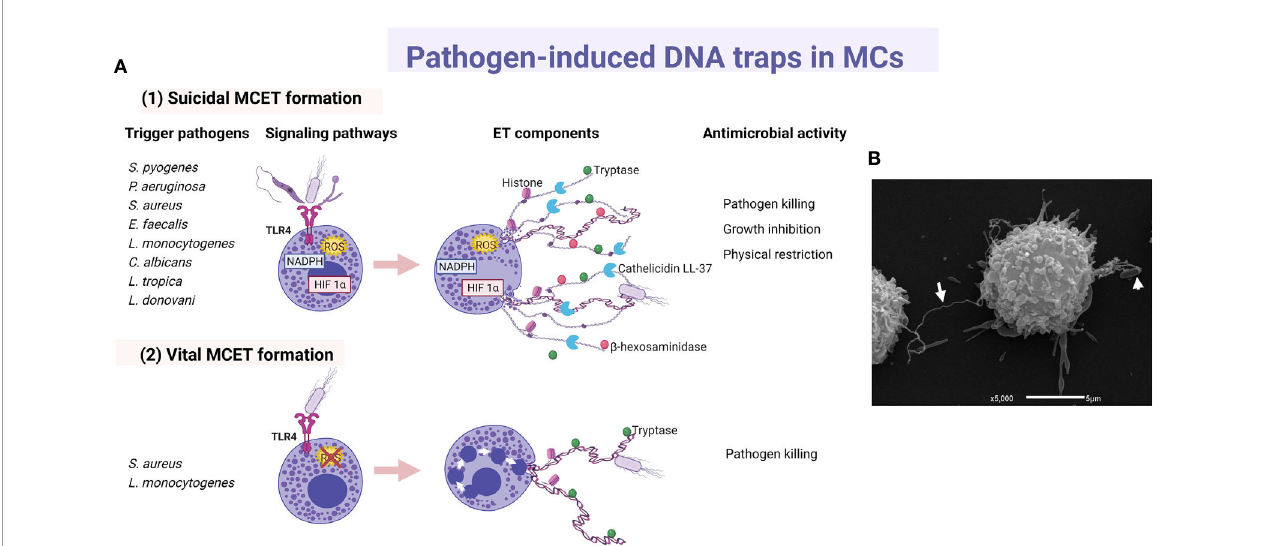
FIGURE 3 | Main characteristics of pathogen-induced MC extracellular traps. (A) Principal triggers, activated signaling cascades and components of (1) suicidal and (2) vital MC extracellular traps (MCET) leading to distinct antimicrobial activity. (B) Scan electron micrograph of MCET (white arrow) emerging from a bone marrow- derived mast cell in the presence of E. coli (white arrowhead). ET, extracellular traps; HIF, hypoxia-inducible